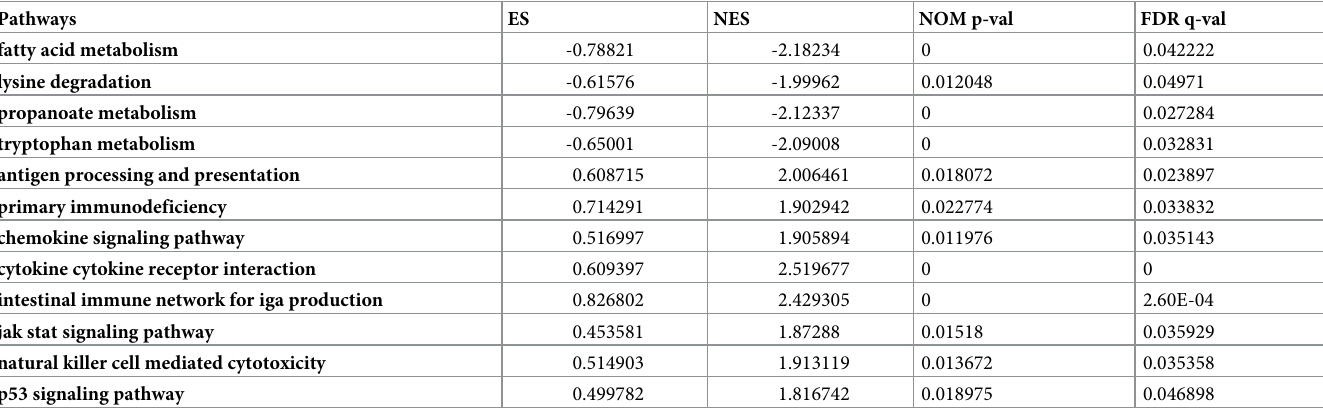
Table 3. Analysis of PLAUR functions by the GSEA